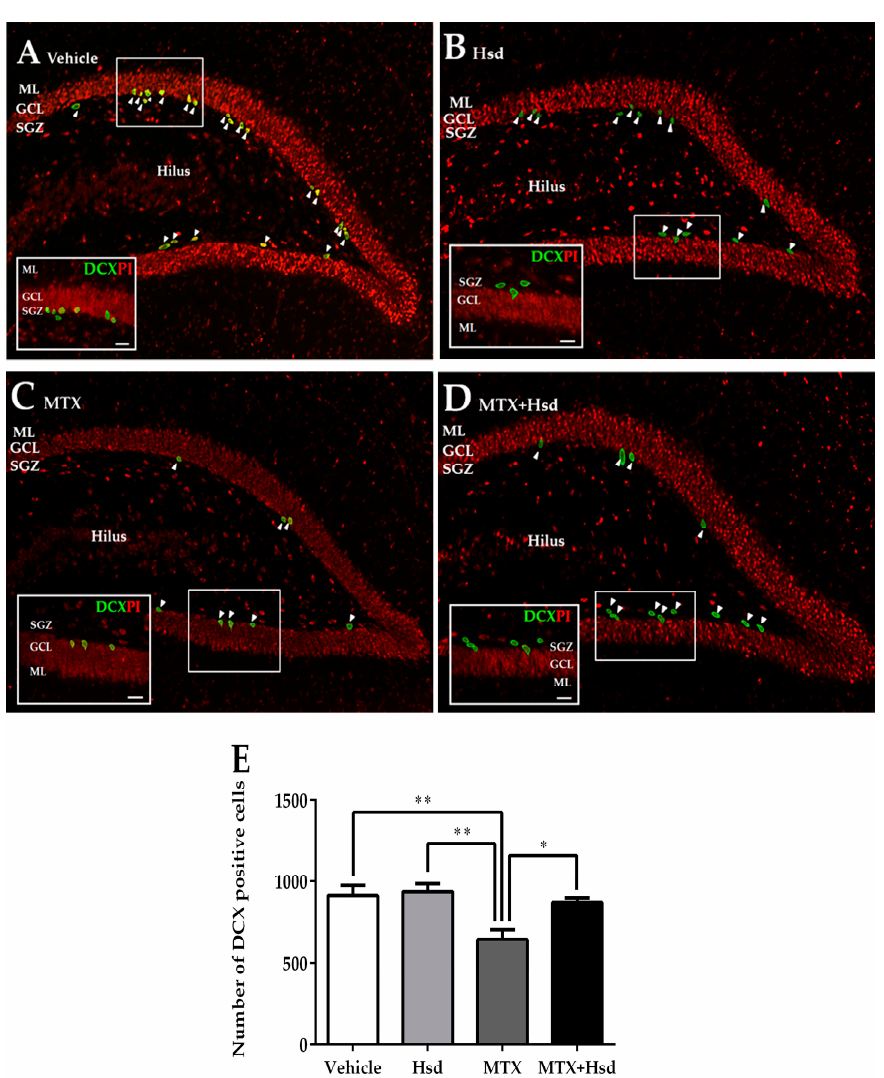
Figure 7. Immunofluorescence staining for DCX (green) in the SGZ of the DG in the hippocampus in the vehicle group ( A ), Hsd group ( B ), MTX group ( C ), and MTX + Hsd ( D ) group. The animals in the vehicle, Hsd, and MTX + Hsd groups exhibited more cells stained with DCX than the MTX group (Data represent mean ± S.E.M, * p < 0.05 and ** p < 0.01, differed significantly from the MTX group) ( E ). SGZ: subgranular zone; GCL: granule cell layer; ML: molecular layer.